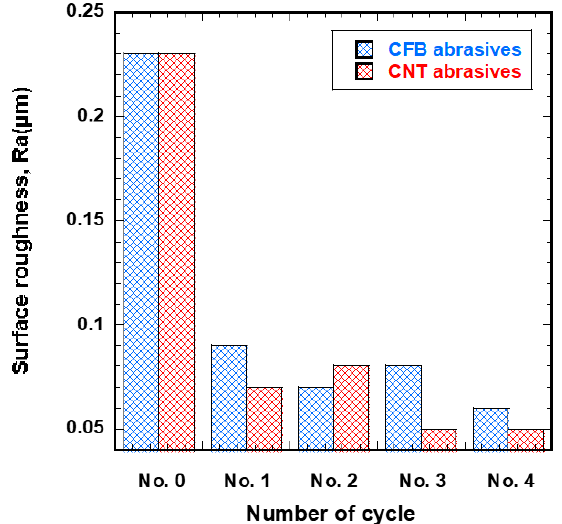
Figure 8. Correlation between surface roughness, Ra, and number of finishing cycles for different magnetic abrasive tools.